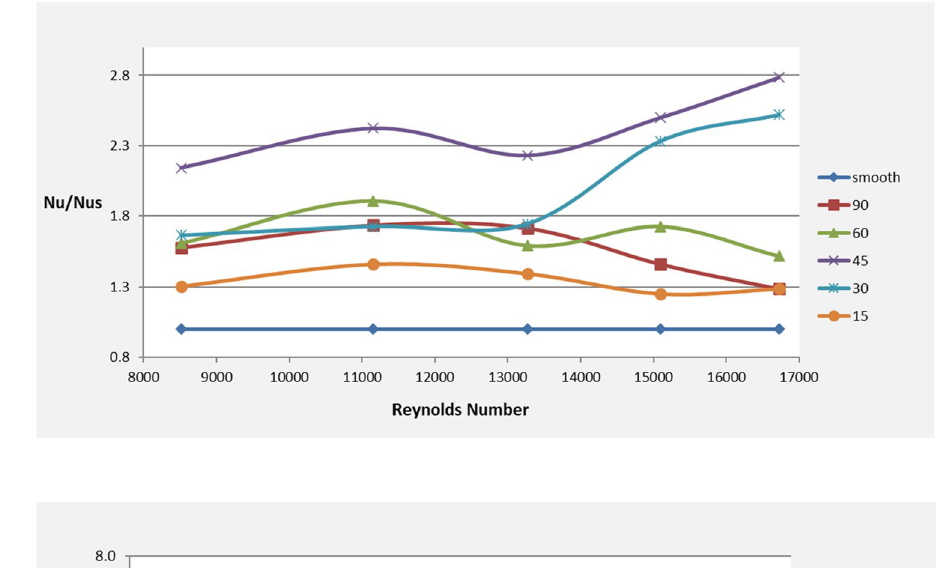
Fig. 8 Variation of f/fs with Reynolds Number at P/D = 4